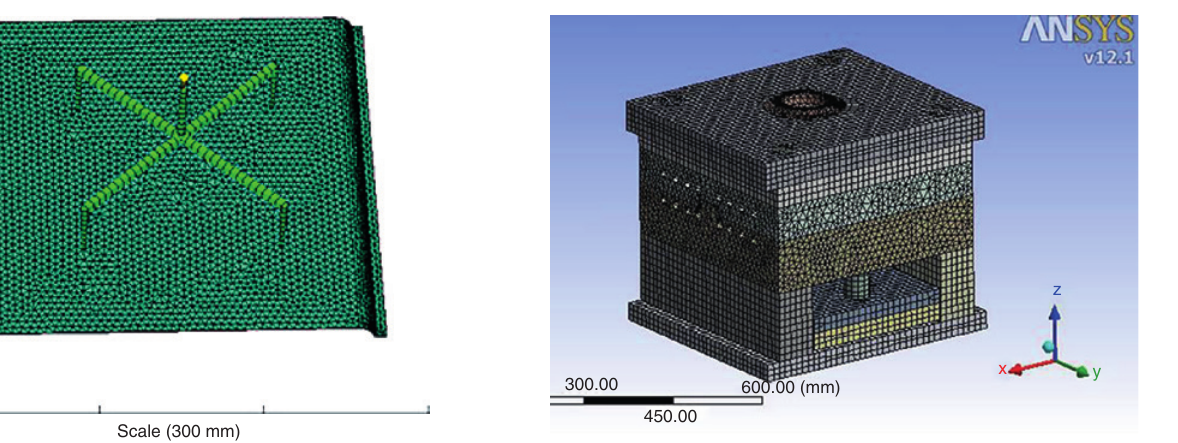
Figure 4: The finite element model of mould.